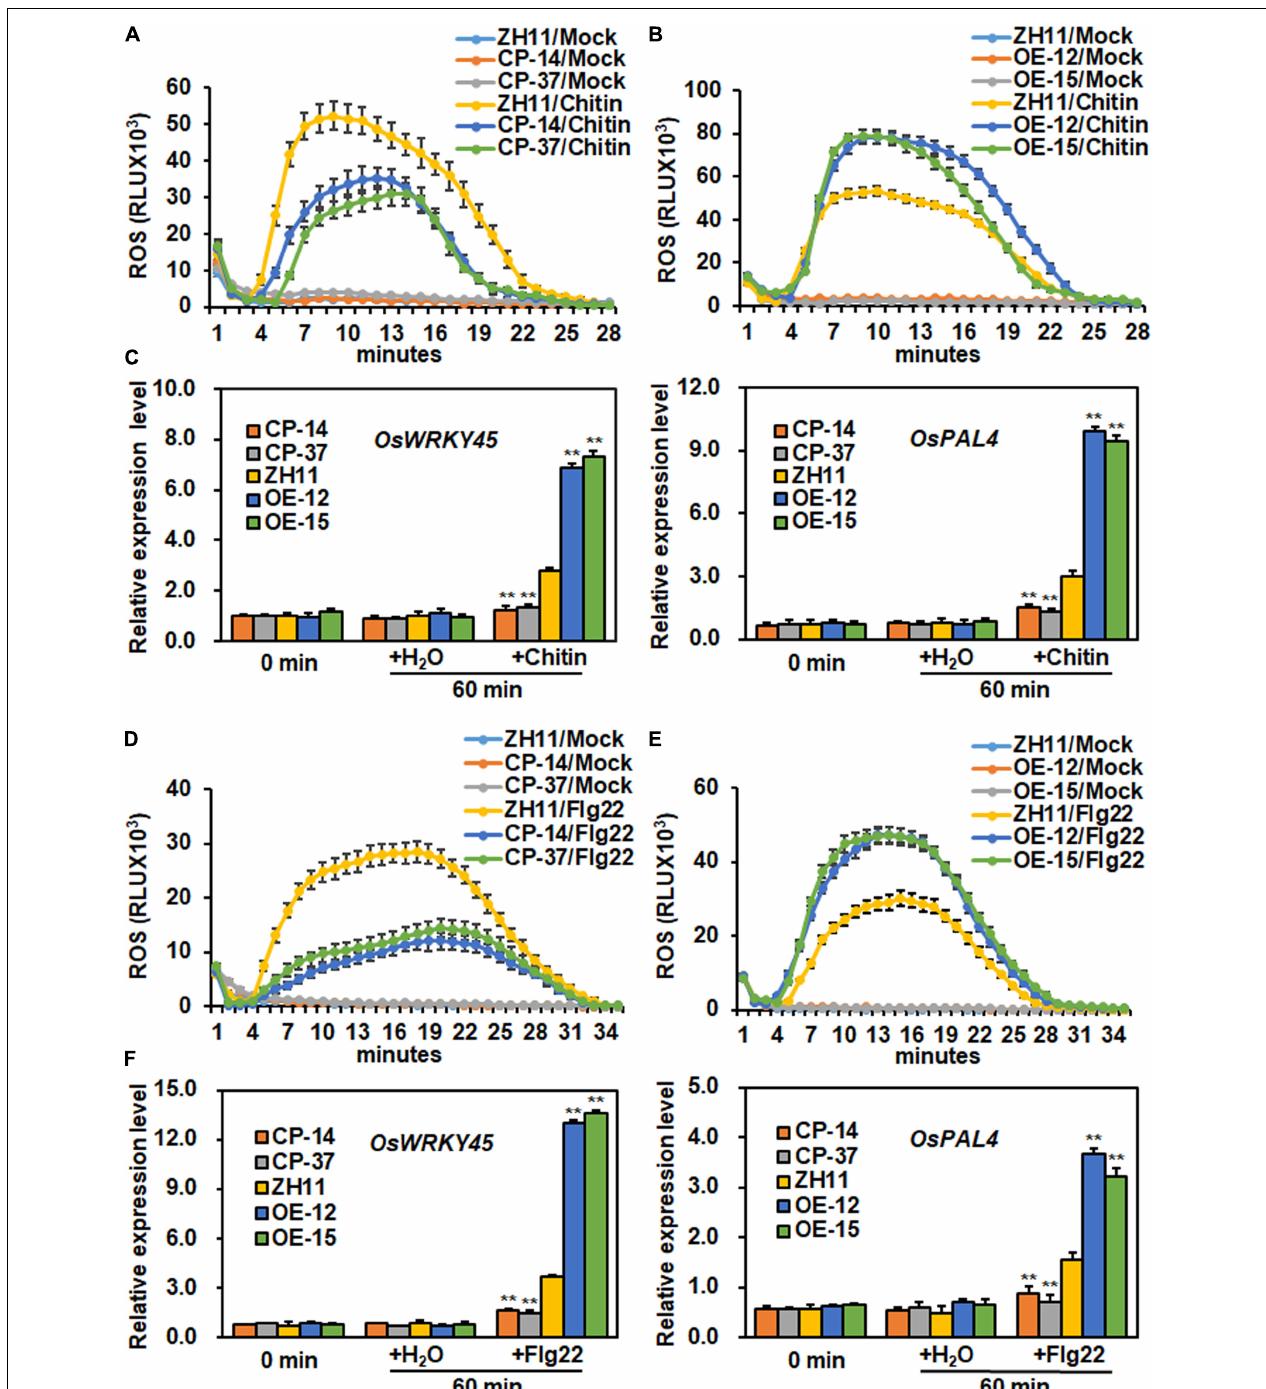
FIGURE 5 | ONAC096 positively regulates chitin- and flg22-induced PTI in rice. (A,B) Chitin-induced ROS burst in ONAC096 -CP plants (A) and ONAC096 -OE plants (B) . (C) Expression changes of PTI marker genes in ONAC096 -CP and ONAC096 -OE plants after chitin treatment. (D,E) Flg22-induced ROS burst in ONAC096 -CP plants (D) and ONAC096 -OE plants (E) . (F) Expression changes of PTI marker genes in ONAC096 -CP and ONAC096 -OE plants after flg22 treatment. Leaf discs from 4-week-old plants were treated with 1 µ M chitin, 100 nM flg22 or water and the chemiluminescent signal was immediately monitored at a 1 min interval over a period of 30 min. Results are presented as relative luminescence units (RLU) in panels (A,B,D,E) . Leaf samples were collected at 60 min after treatment with 10 nM chitin, 100 nM flg22 or water for analysis of gene expression. Relative expression of PTI marker genes were shown as folds of the expression level of the 18S rRNA gene (C,F) . Experiments were repeated for three times with similar results. Data presented are the means ± SE from three independent experiments and asterisks (C,F) indicate significant difference ( p < 0.01, Student’s t test) in comparison to WT.